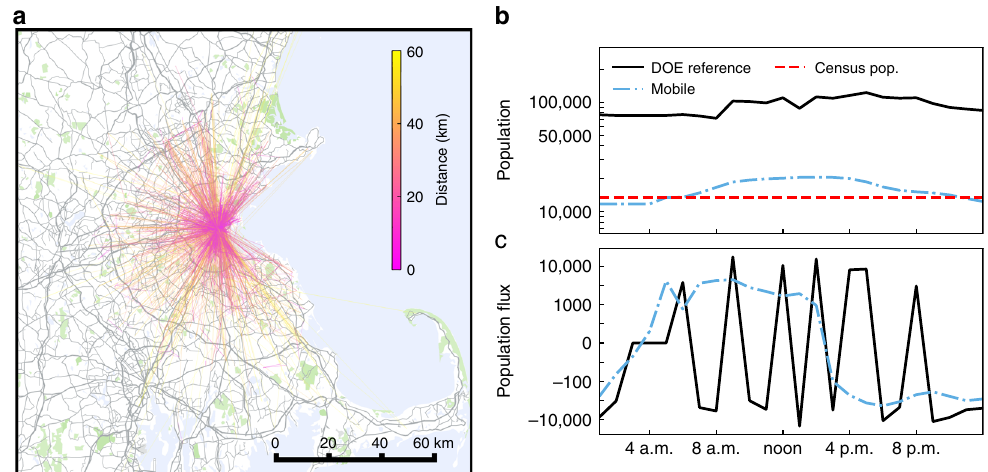
Fig. 2 Residents and visitors in the Back Bay. a Predicted journeys from the TimeGeo for users who visit the fi ve tracts shown in Fig. 1c. Each line represents approximately 50 users. b The total predicted hourly occupancy for the area shown in Fig. 1c according to the TimeGeo model and as implied by the DOE reference building model. The census population for the area is also shown. c The predicted population fl ux as implied by the reference buildings and TimeGeo model. Map created using Google Maps, 2019